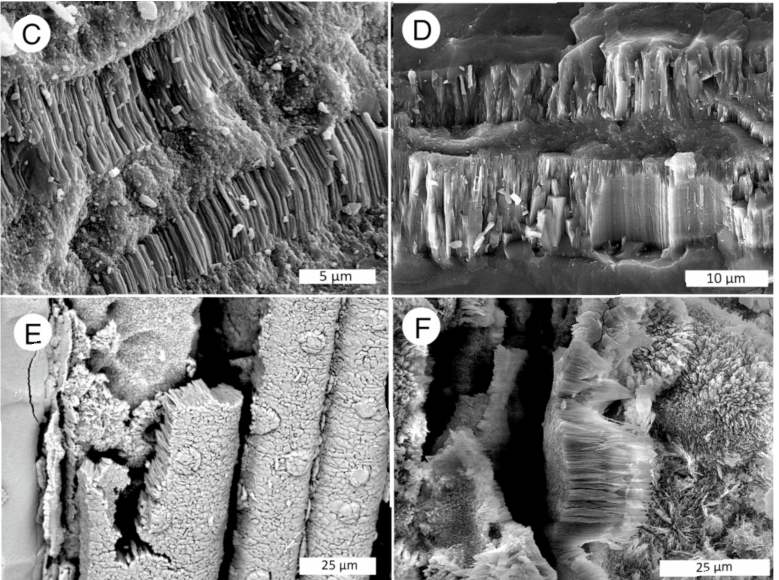
Figure 30. SEM views of chalcedony in Miocene fossil wood. ( A ) Blakeley Formation, northwest Washington, USA. ( B ) Northwest Iran. ( C ) Saddle Mountain, central Washington, USA. ( D ) Goose Creek, northern Nevada, USA. ( E ) Radial view showing chalcedony replacing cell wall and pit apertures. Lumen are empty. Yakima Canyon, central Washington, USA. ( F ) Fibrous chalcedony replacing cell wall. Saddle Mtn, central Washington, USA. Images ( E , F ) are from specimens that were treated for 60 sec with 40% HF to show mineral structure. HF treatment removes interstitial silica that would otherwise cause cell wall surfaces to appear smooth.